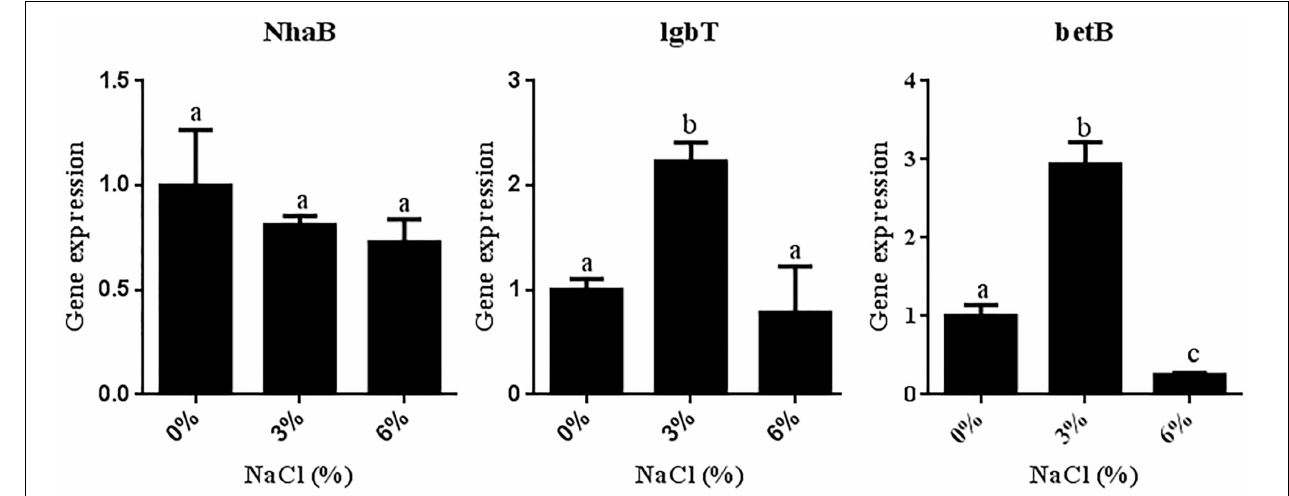
FIGURE 6 | Differential expression of salt tolerance-related genes in R. aquatilis JZ-GX1 in the presence of different salt concentrations. The vertical bars represent the standard deviations of the averages. One-way ANOVA was performed, and Duncan’s post hoc test was applied. Different letters indicate significant differences ( P < 0.05) among the